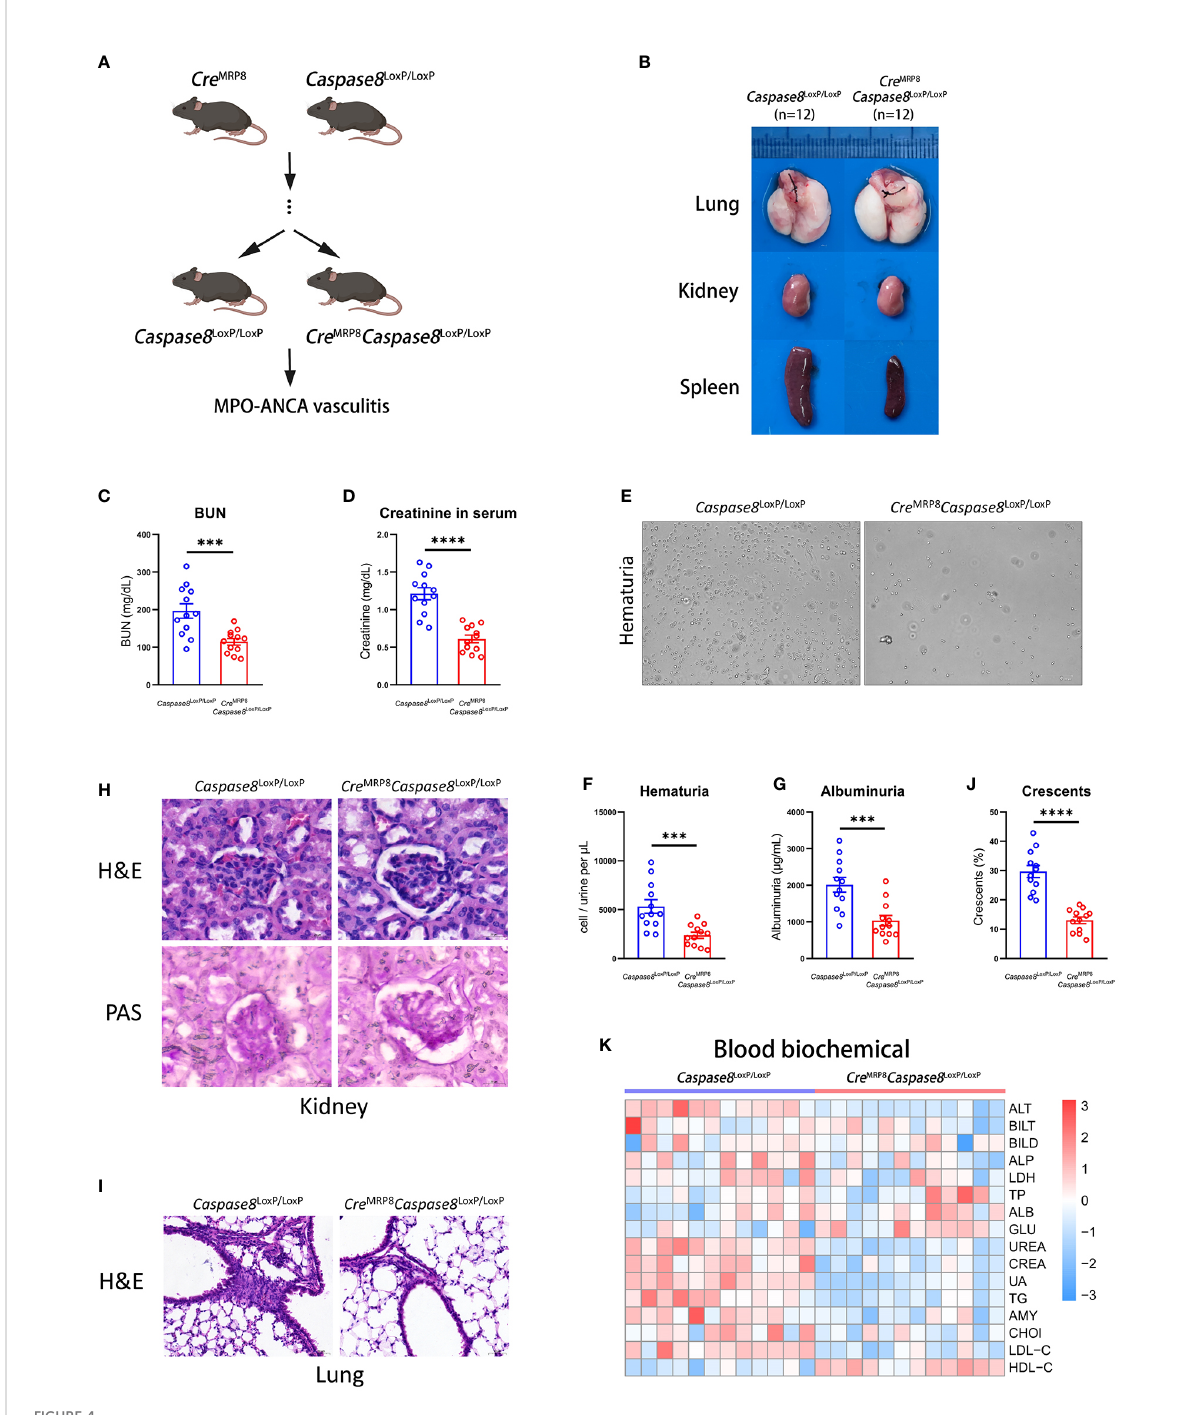
FIGURE 4 The caspase-8 knockout in neutrophils alleviates systemic vasculitis in mice. (A) Breeding strategies of Cre MRP8 Caspase8 LoxP/LoxP mice. (B) The representative pictures of lung, kidney and spleen from Caspase8 LoxP/LoxP and Cre MRP8 Caspase8 LoxP/LoxP mice. (C, D) The comparison of urea nitrogen (C) and creatinine (D) in mouse serum between two groups. (E) The representative pictures of urine smear from groups. (F, G) The comparison of hematuria (F) and albuminuria (G) between Caspase8 LoxP/LoxP and Cre MRP8 Caspase8 LoxP/LoxP mice. (H, I) H&E and PAS staining images of the kidney (H) and H&E staining images of the lung (I) from two groups. Scale bar, 20 m m. (J) The summarized number of crescents according to H&E images. (K) The detection of biochemical criteria in mouse serum from Caspase8 LoxP/LoxP and Cre MRP8 Caspase8 LoxP/LoxP mice. ***P < 0.001, ****P <